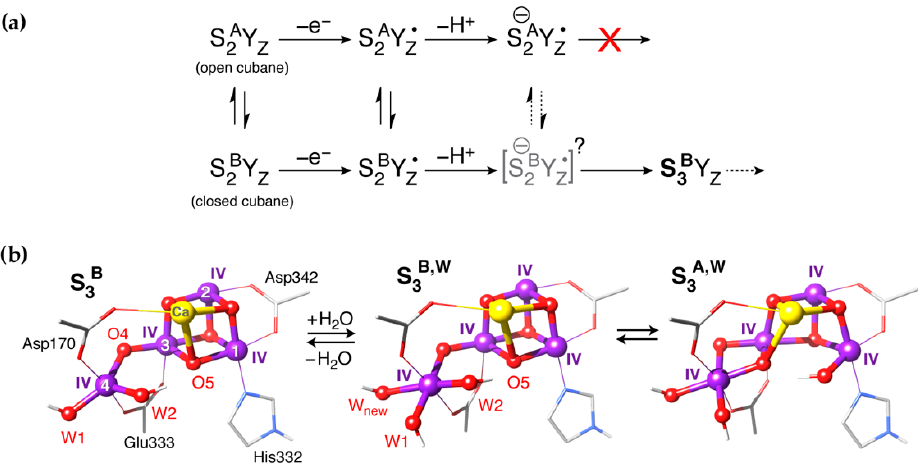
Figure 5. ( a ) Schematic diagram of the progression from the S 2 to the S 3 state as proposed by Retegan et al. [104]. Deprotonation is favored in the open cubane isomer of S 2 , but Mn oxidation by the tyrosyl radical is blocked in the deprotonated open cubane isomer. However, it is possible in the closed cubane form, which can advance directly to S 3 state, without requirement for water binding; ( b ) proposed constituent forms of the S 3 state: S 3B is assumed to describe the population that is still unobserved by EPR, which absorbs at NIR leading to creation of the S 2 Y Z · ′ state that bears the spin-signature of a closed cubane subunit [104]. S 3A,W is structurally equivalent to the oxo–hydroxo species in Figure 4b; the progression shown here implies a potential equivalence through translocation and proton shift